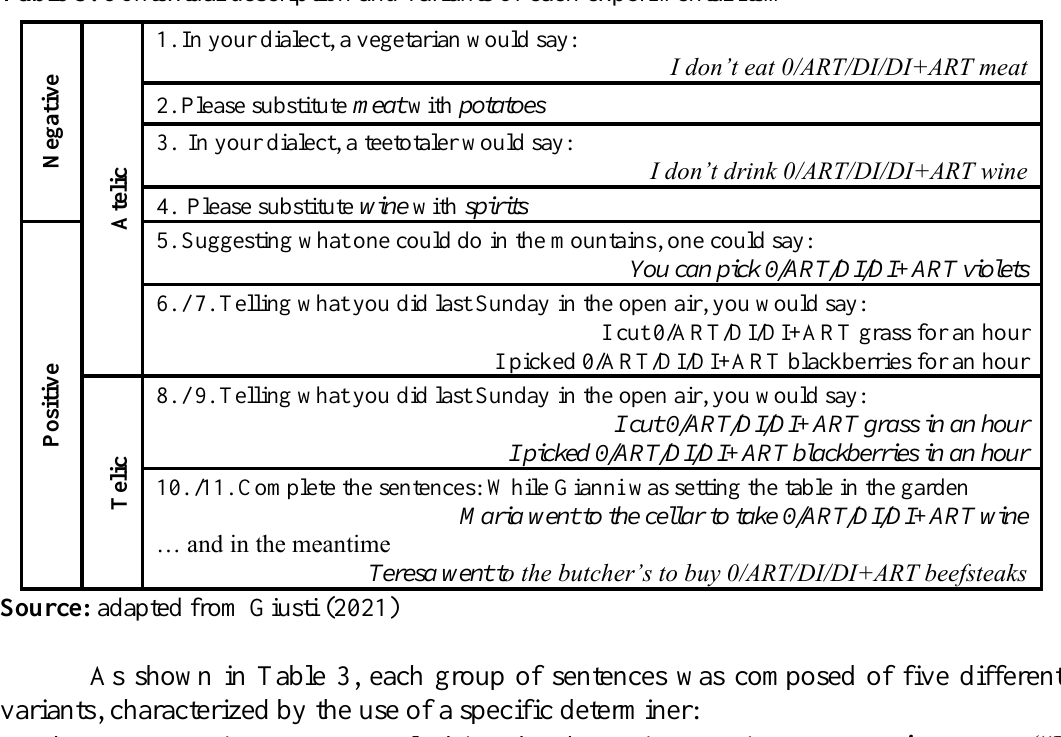
Table 3. Contextual description and variants of each experimental item